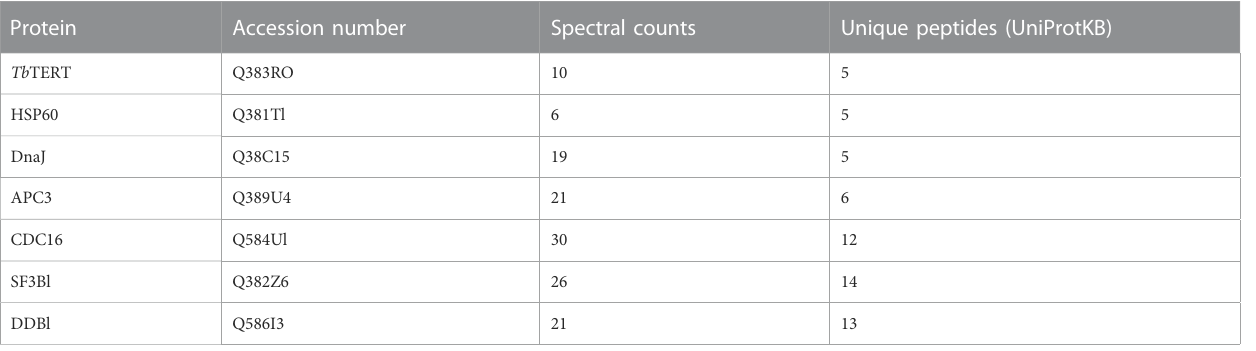
TABLE 1 Signi fi cantly enriched proteins identi fi ed in Tb TERT